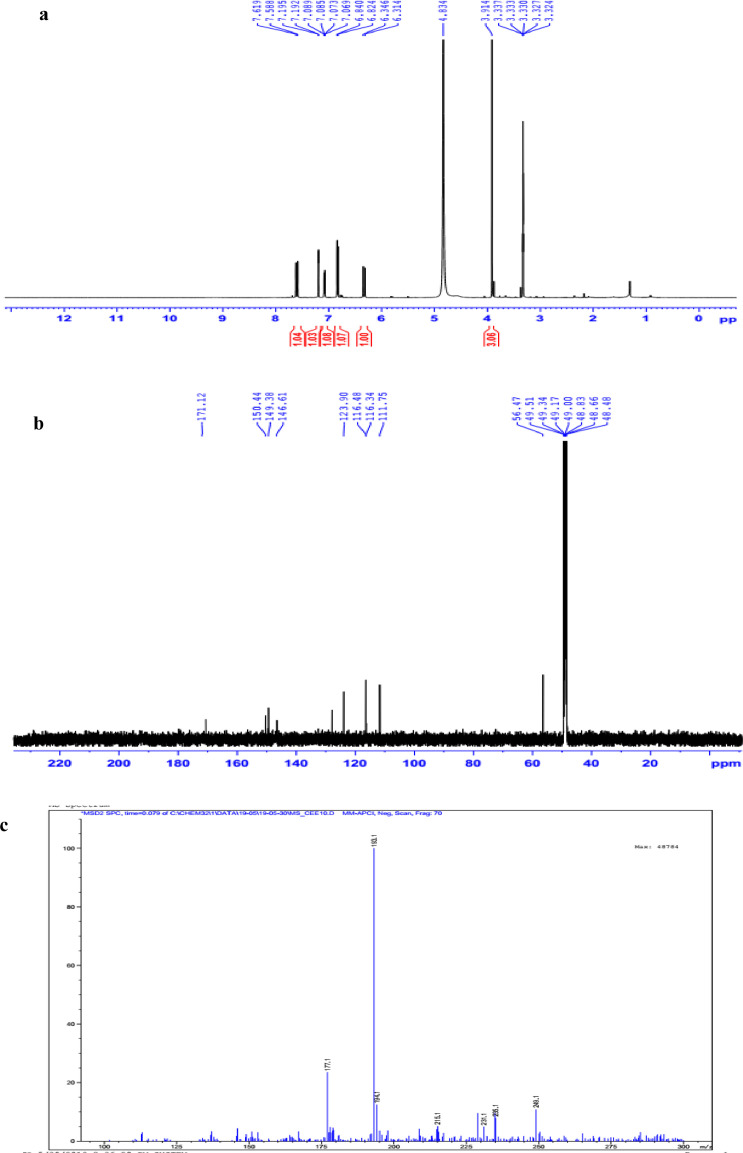
a. 1H NMR (500 MHz, CD3OD) of 4, b. 13C NMR (125 MHz, CD3OD) of 4, c. (-) APCI-MS of 4.1D NMR, and APCI-MS of the compound 5 are shown in Fig. 6a-c.